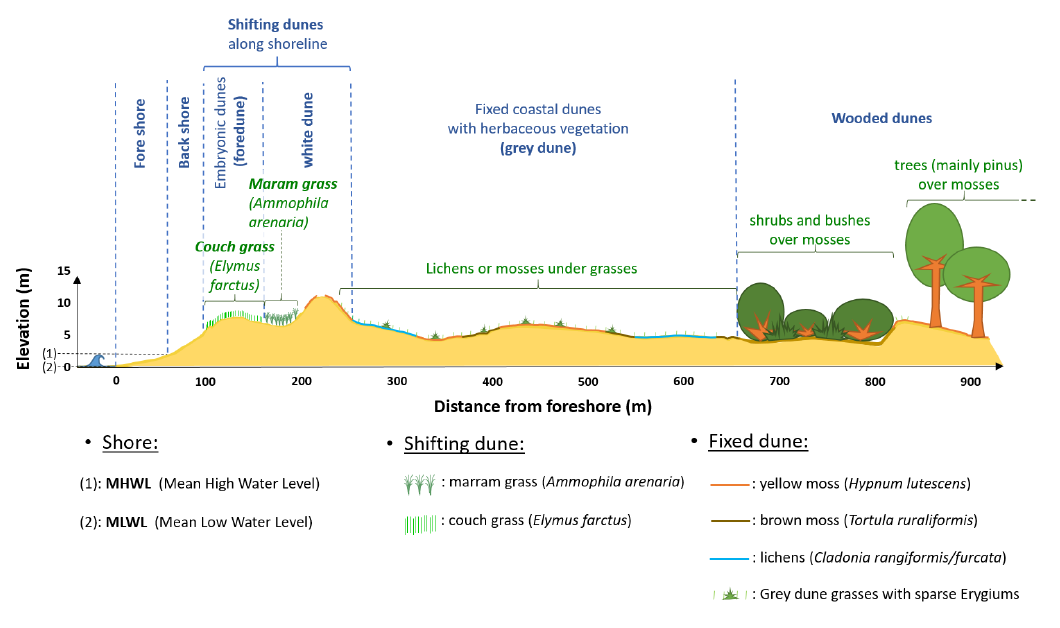
Figure 1. A typical western French sandy coast profile. The morphological terminology is written in blue and typical vegetation cover is written in green. Note that the distance scale from the foreshore is only indicative and can vary from one area to